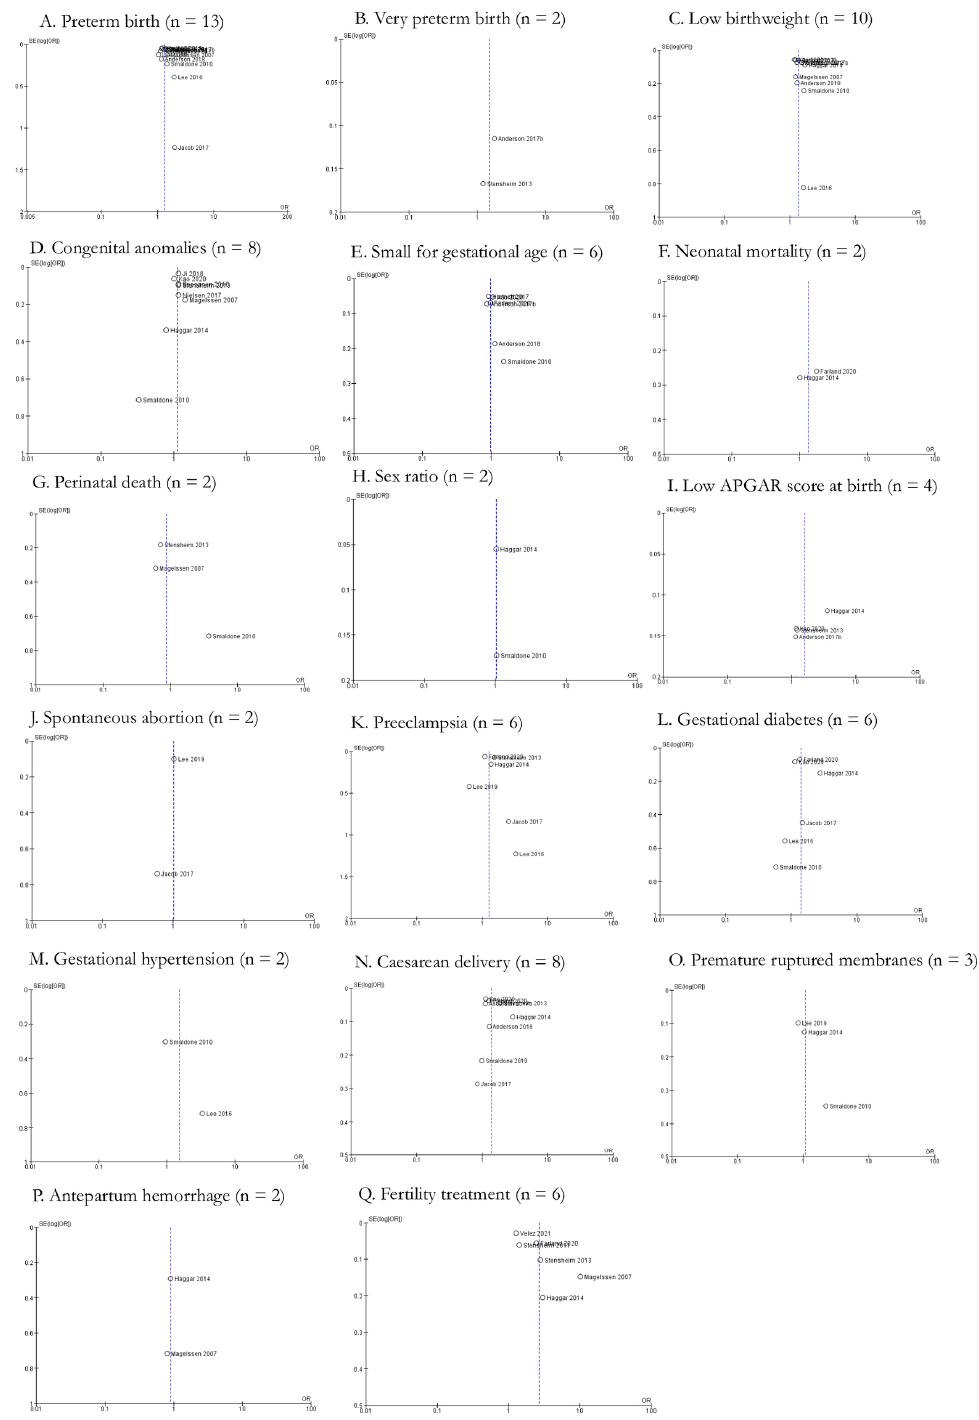
Figure 5. Funnel plots of meta-analyses of AYA cancer and reproductive health outcomes (n = 17).